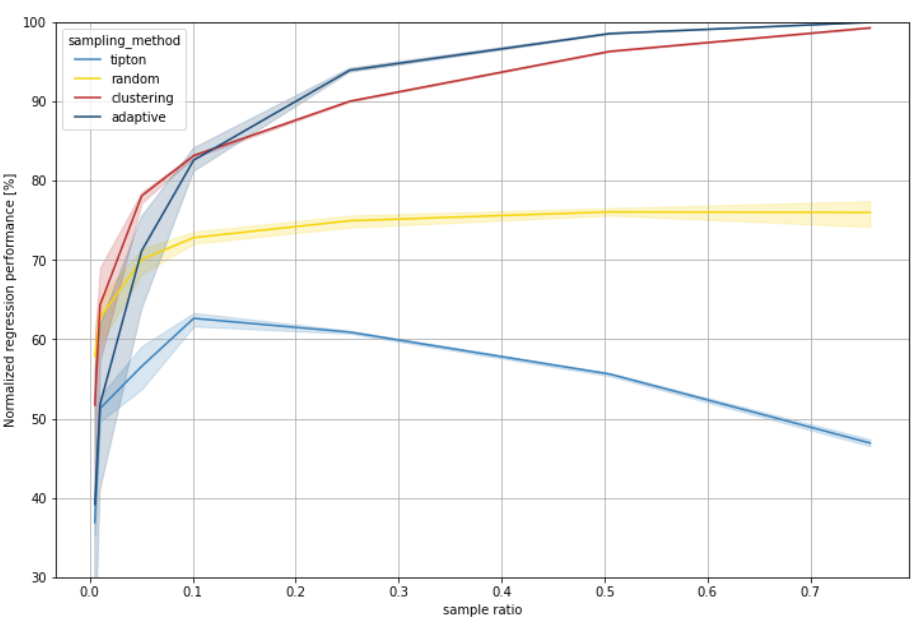
Figure 6. Impact of sampling methods on dataset 2.